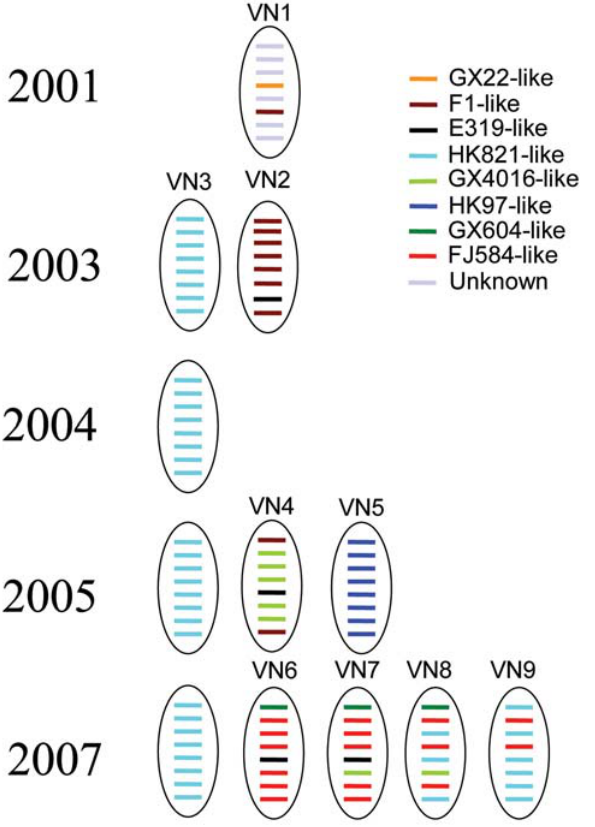
Figure 2. Emerging HPAI H5N1 genotypes from introduction and reassortment in Vietnam from 2001 to 2007. Each segment was marked in a different color corresponding to its putative precursor virus. The segment numbers are ordered 1 to 8 from top to bottom. Table 3 shows the H5N1 viruses from Vietnam that represent each genotype and other information.